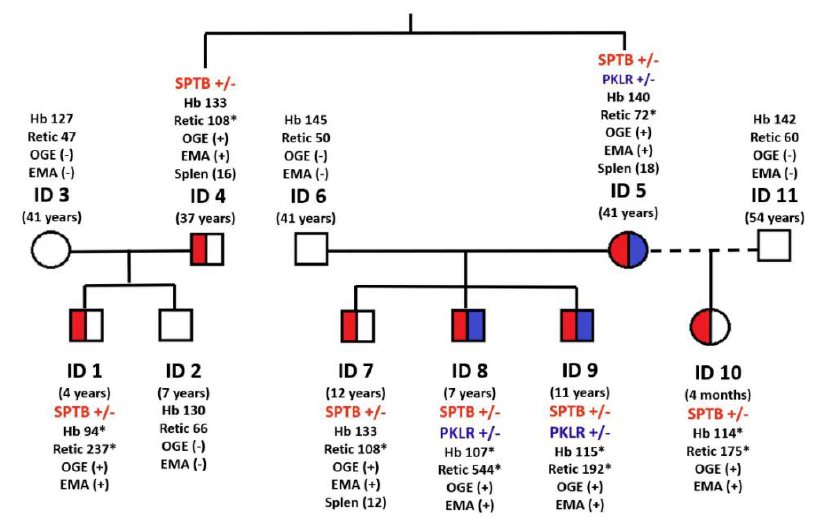
Figure 1. Family tree Scheme 647. G> A (p.Arg216Gln), in beta-spectrin gene; PKLR (+/ − ): heterozygous mutation, c.1706G>A (p.Arg569Gln), in pyruvate kinase gene; Hb: hemoglobin (g/dL); Retics: reticulocytes ( × 10 9 /L); OGE: osmotic gradient ektacytometry, (+) profile characteristic of HS, ( − ) normal profile; EMA: EMA-binding test (+) positive; ( − ) normal; Spleen (age of splenectomy);